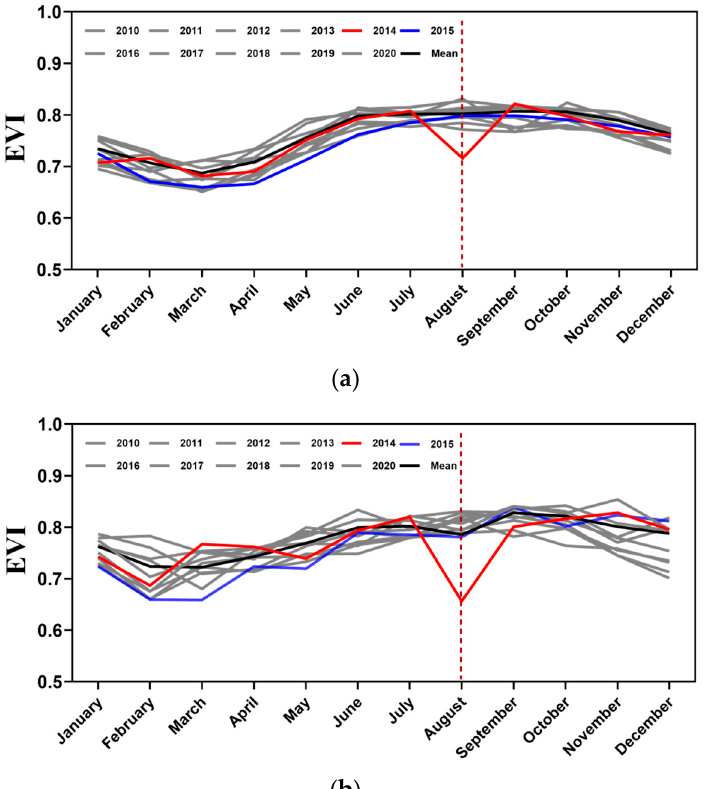
Figure 11. Landsat-based monthly average EVI for the affected forest areas by Rammasun during 2010–2020 (( a ): Guangdong; ( b ):